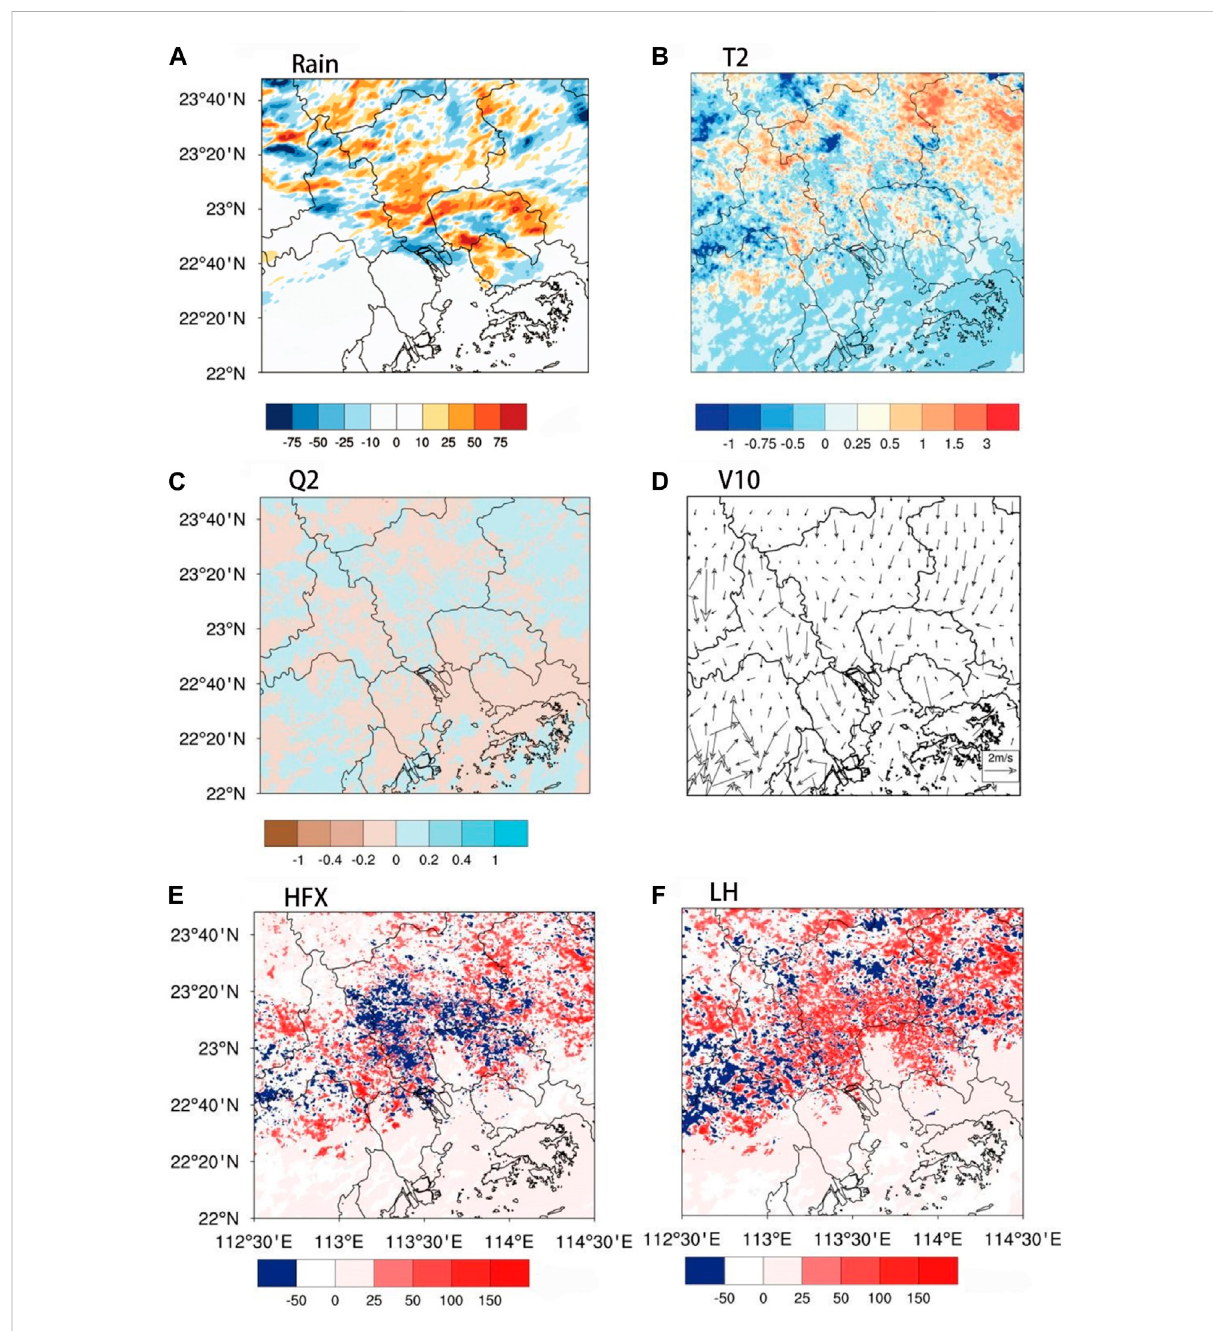
FIGURE 7 Difference between the urb5w_5ah and urb1w_1ah experimental groups in their simulation of meteorological elements from 0,800 to 2000LST 20 April: (A) cumulative precipitation (unit: mm); (B) average 2 m temperature (unit: ° C); (C) average 2 m speci fi chumidity (unit: g · kg − 1 ); (D) average horizontal wind (unit: m · s − 1 ) (in the fi gure, the stronger the north wind in urban areas, the larger the urban deceleration and convergence effect); (E) average surface upward sensible heat fl ux (unit: W · m − 2 ); (F) average surface upward latent heat fl ux (unit: W · m − 2